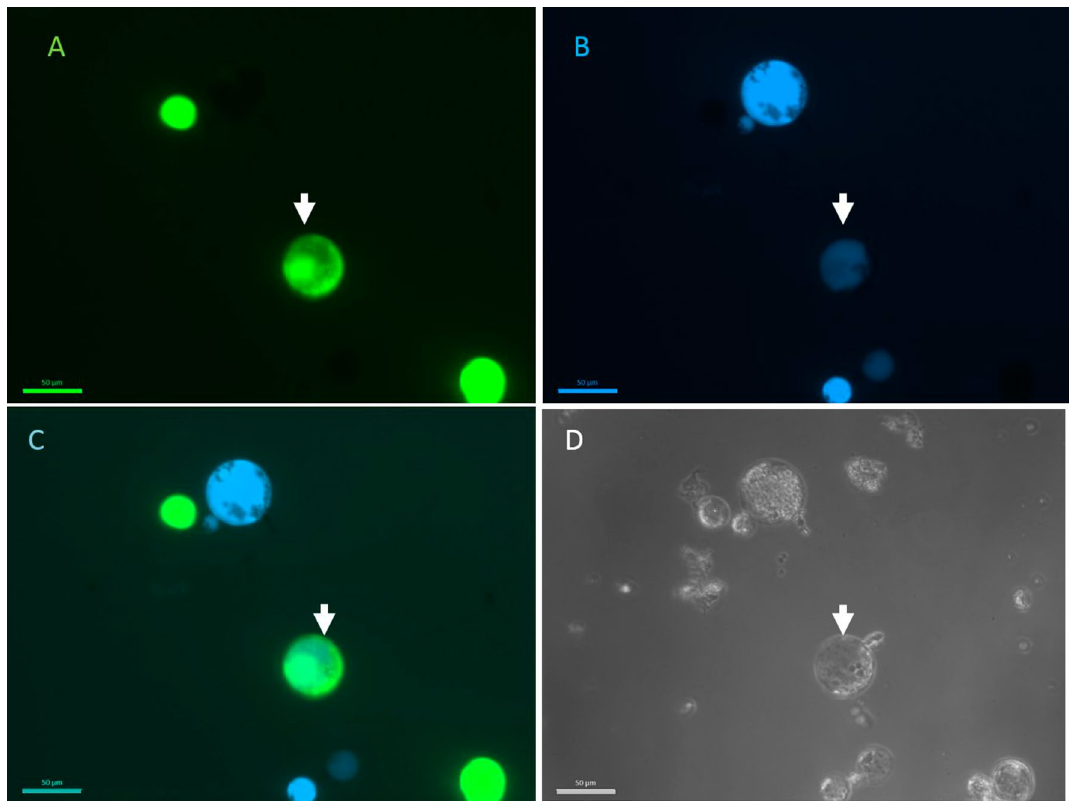
Figure 1. Celeriac and coriander protoplast fusion. Celeriac protoplasts were stained with FDA ( A ) and coriander protoplasts with calcein blue ( B ). Overlap between the photos taken with separate filters showing dual staining ( C ). All cells were visible in bright field ( D ). The arrow indicates the hybrid cell. The scale bar is 50